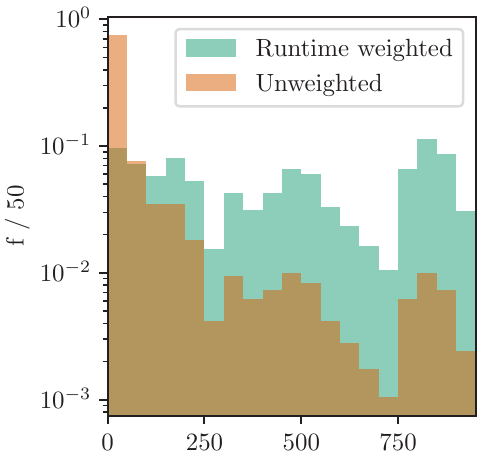
Figure 1. Illustration of the processing carried out by the DFE and host CPU and the movement of data between them. Figure 2. Histogram of the number of Kalman Filter state and hit combinations that can be bu ff ered and sent to the DFE in one iteration. As well as the count, the fraction of time spent processing that number of updates on the CPU is Table 2. Resource usage and timing metrics of the Kalman Filter state updater, and peripheral communications, on a Maia DFE. Resources are also expressed as a percentage of the Altera Stratix V 5SGSD8 device used.